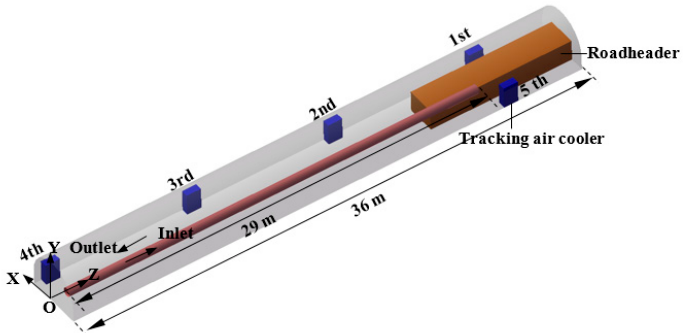
Figure 4. Physical model of the excavation roadway with forced ventilation for the numerical simulation.